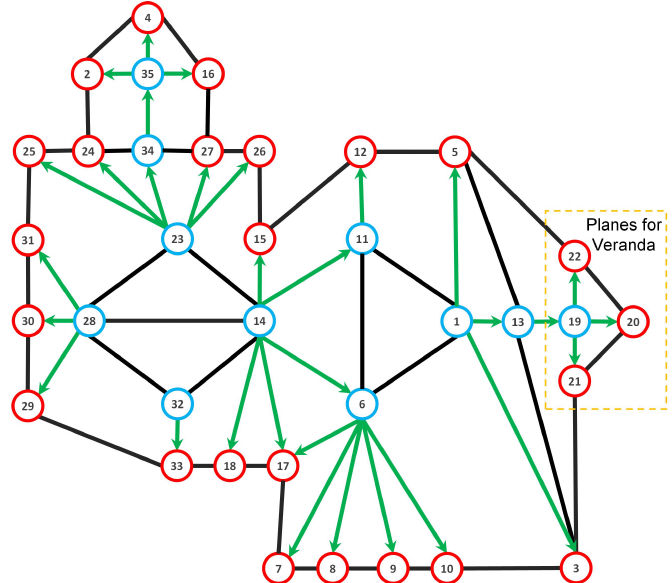
Figure 12. A graph (data structure) for a building model shown within the orange rectangle in Figure 10a: roof planes are blue nodes; wall planes are red nodes; parent-to-child connections are in green edges (where an arrowhead indicates a child side); and sibling connections are in black